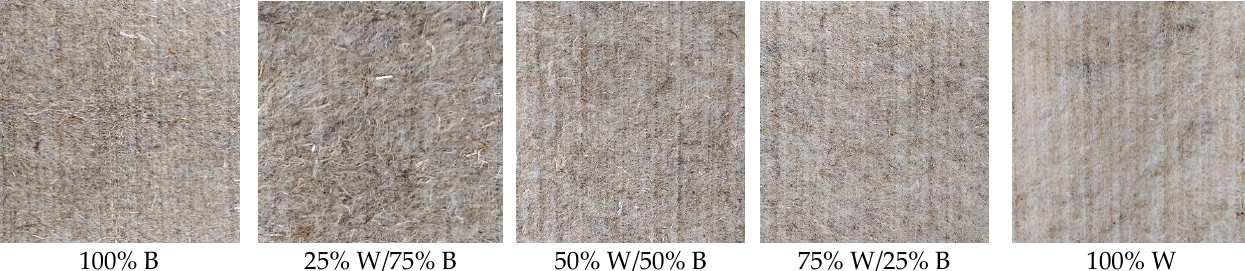
Figure 1. Photographs of the manufactured mats.